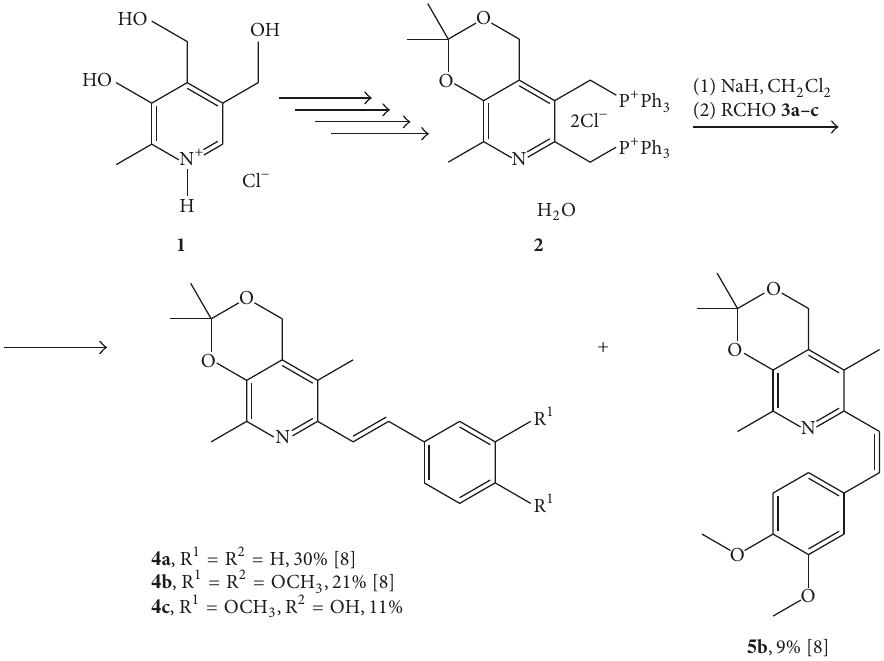
Scheme 1: Synthesis of compounds studied in this work.